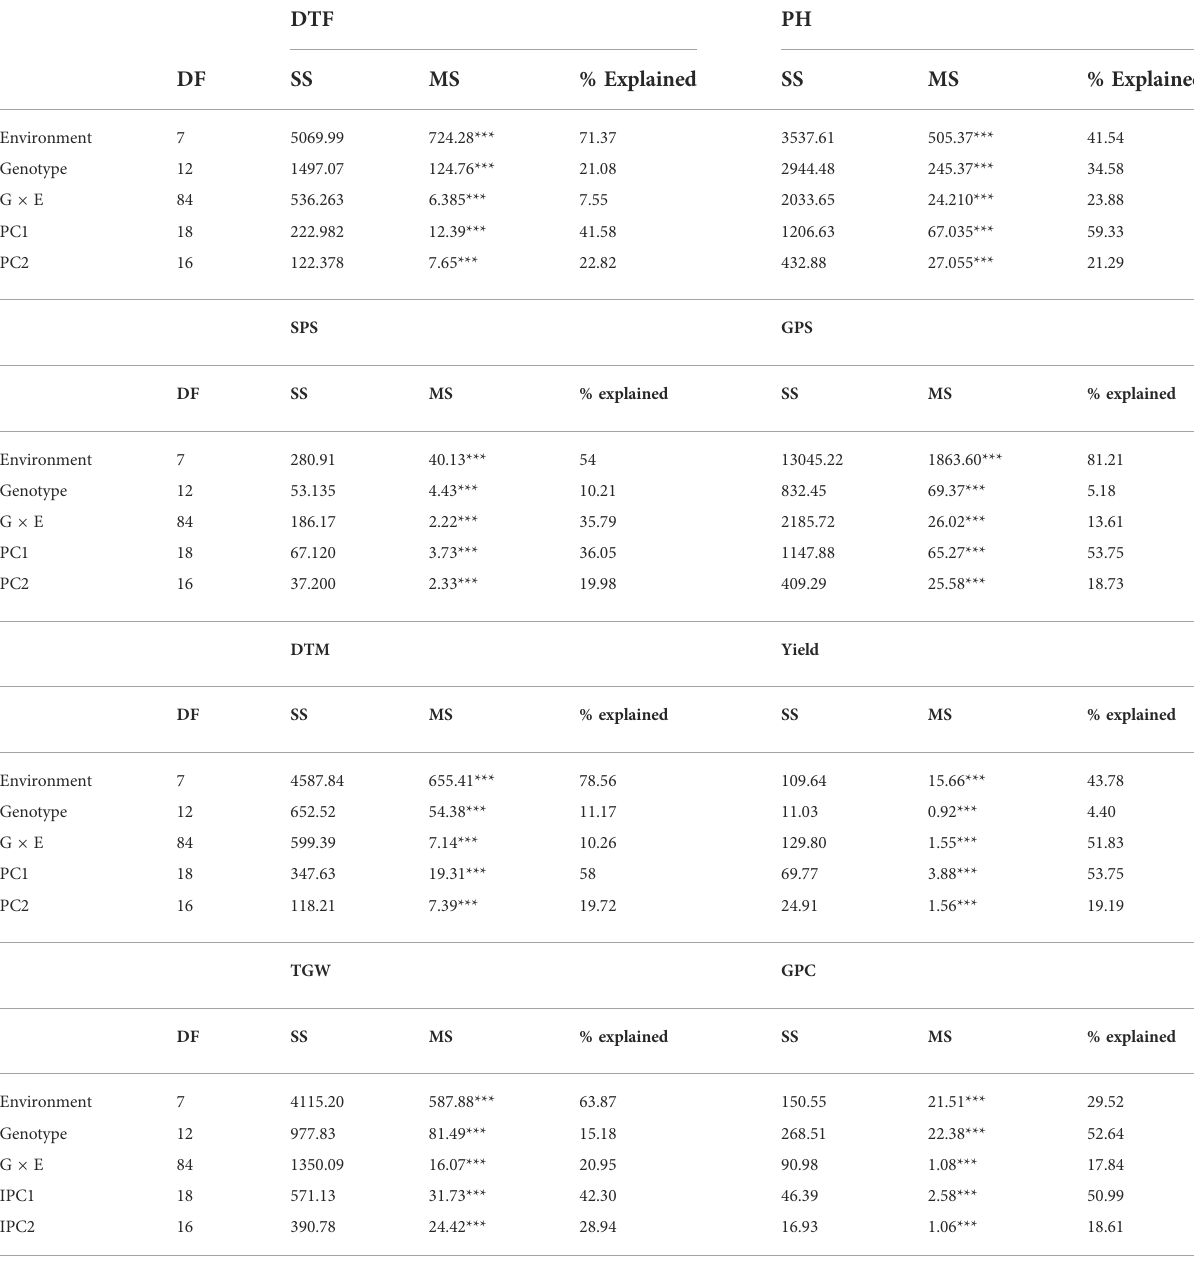
TABLE 5 AMMI-based ANOVA for yield, GPC and their related traits of 13 bread wheat genotypes across four locations (Ludhiana, Ballowal, Patiala, and Bathinda) of Punjab in two consecutive years 2019 – 20, and 2020 –